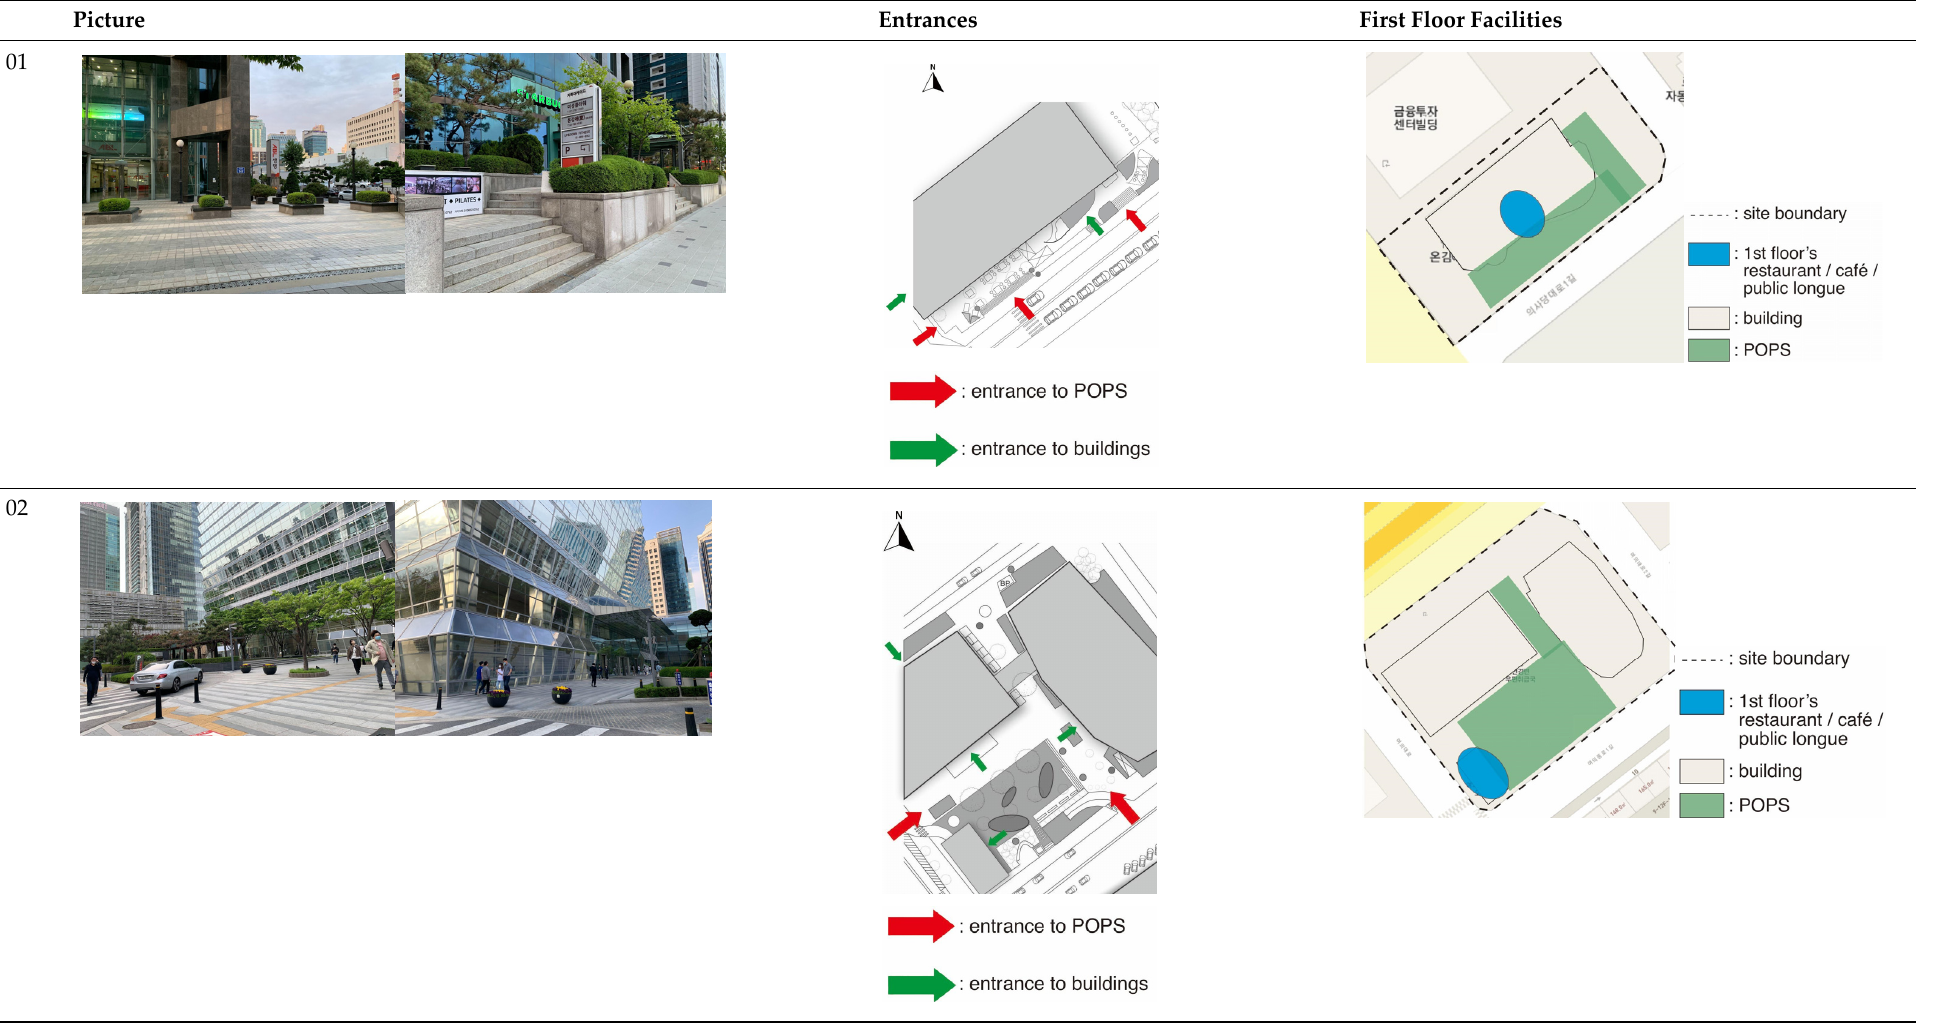
Table 2. The physical relationship between the POPS and the buildings on the site, shown by the entrance designs and the availability of public facilities such as restaurants and cafes on the first floor.